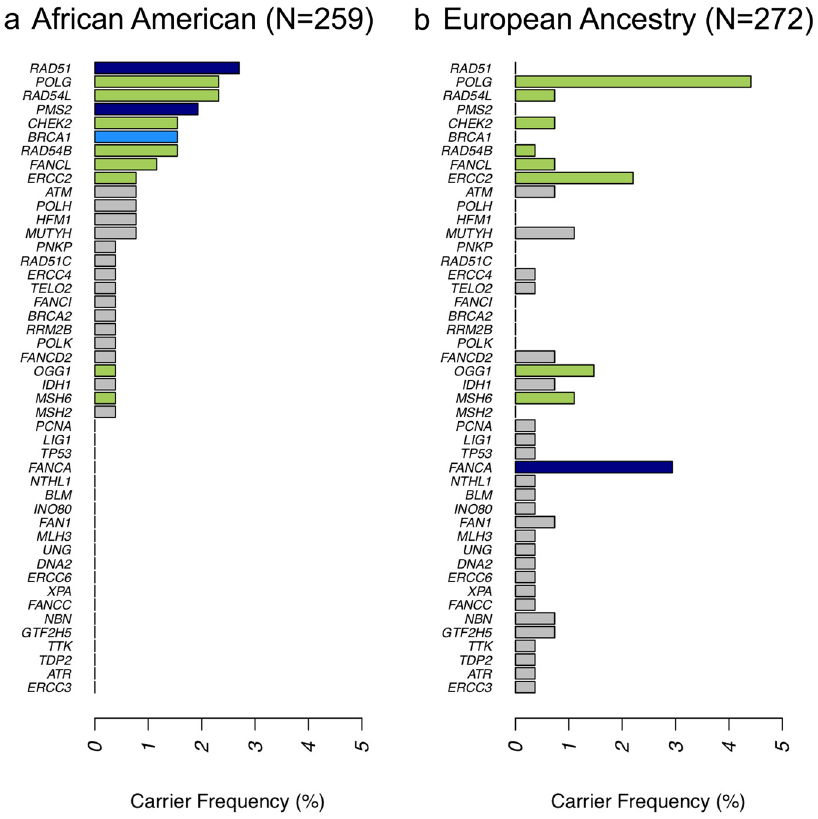
Fig. 2 Germline Mutation Carrier Rate in Prostate Cancer Cases. Carrier frequencies were calculated as the proportion of patients carrying at least one rare germline mutation on the DNA Damage Response Gene (DDRG). a Germline mutation carrier frequency in mutated DDR genes in African American (AA) cohort. b Germline mutation carrier frequency in mutated DDR genes in cohort of men with European Ancestry (EA). DDR genes with at least three carriers in CPDR cohort of AA or EA men are tested. A two-sided Fisher Exact Test was performed to assess the p values. Colors of the bars indicate Fisher Exact Test P values of AA vs. EA comparison. Dark blue: P < 0.05; Light blue: 0.05 < P < 0.1; Green: P > 0.1; Gray: not tested. Germline mutations in RAD51 and PMS2 genes are enriched in African American cohort as compared to EA men with P values of 0.0063 and 0.0271 respectively. Germline mutations in FANCA gene is enriched in EA men (Fisher P value is 0.0075). Genes were sorted by carrier rate in AA cohort. Source data are provided as a Source Data fi le.